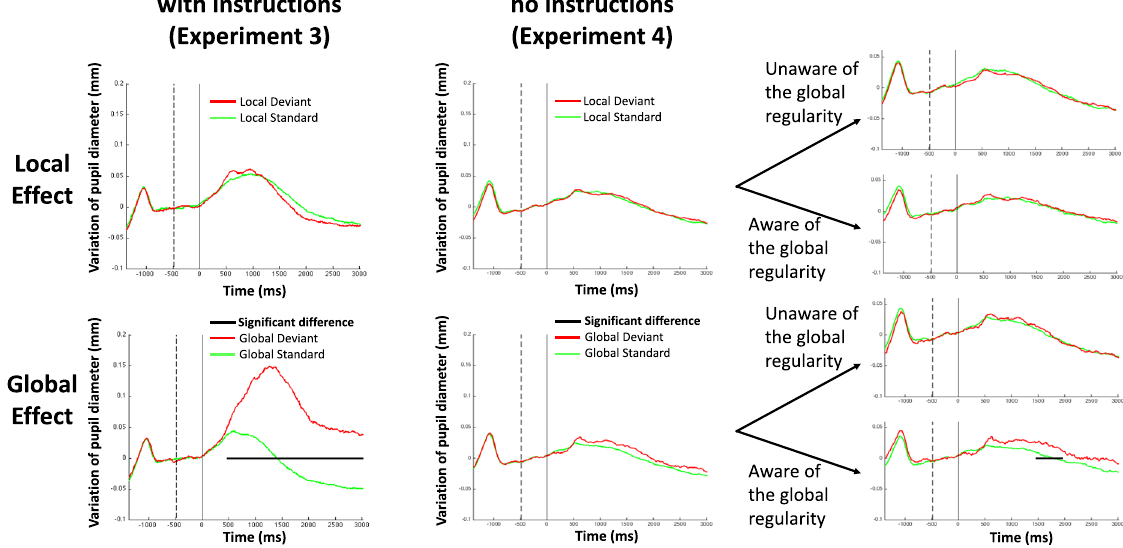
Figure 5. The pupil local and global effects in a phonemic version of the task Results of Experiments 3 and 4. Grand-averages of the variation of both pupil diameters (in mm) are plotted over time (in milliseconds) both for the local (upper panels) and global (lower panels) effects, with explicit counting instructions (Experiment 3, left panels) or without instruction (Experiment 4, right panels). While the event-related pupil response was undistinguishable between local standard (green curves) and local deviant (red curves) trials, a global effect was observed: a significant (black horizontal segments) pupil dilation was observed in response to global deviant trials. With explicit instructions, this effect began around 500 ms after the onset of the last syllable (time 0), peaked around 1.5 second and was sustained during more than 3 seconds. The effect was shorter and weaker without instructions, and only observed for those participants who were aware of the global regularity. The vertical dotted line indicates the beginning of the baseline period. The vertical solid line indicates the end of the baseline period, which corresponds to the temporal onset of the last syllable of each trial (time